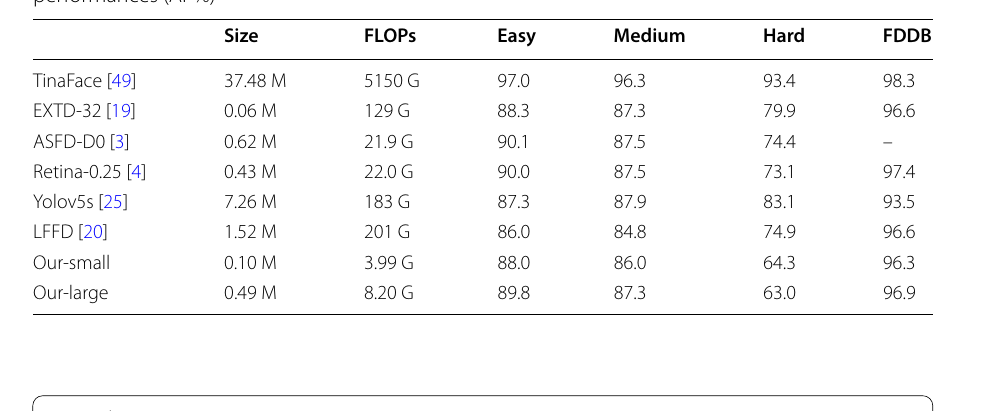
Table 2 is the comparison between the proposed detector and the existing lightweight face detectors. The size column presents the models’ parameters number. The FLOPs column is the FLOPs during inference when input resolution is 4096 posed models have the smallest FLOPs among all the lightweight detectors. The easy, medium, hard, and FDDB column is the average precision (AP) in Widerface test sets and FDDB dataset. The precision-recall curves are shown in Fig. 5. The TinaFace has the best detection accuracy, but the model size is very large. The speed is also far from real-time speed. Retinaface-0.25’s detection accuracy is slightly better than the proposed